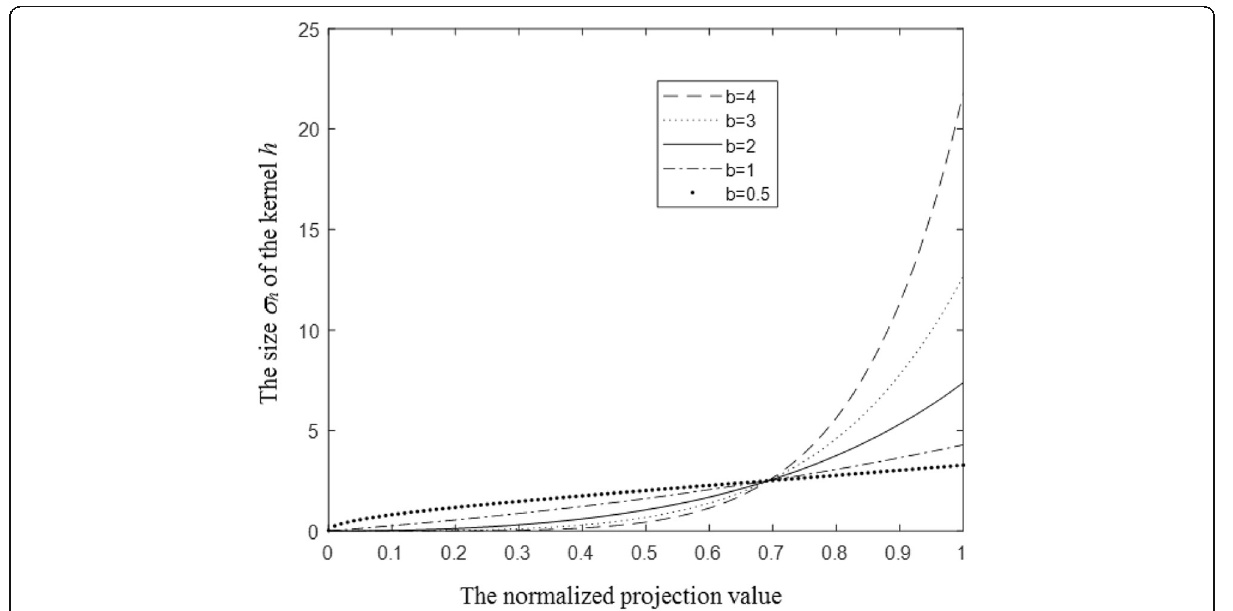
Fig. 9 The functional relationship Eq. (5) of 5 cases as in Figs. 2 to 5, 10, respectively. The horizontal axis represents the normalized projection value, and the vertical axis represents the size σ h of the kernel